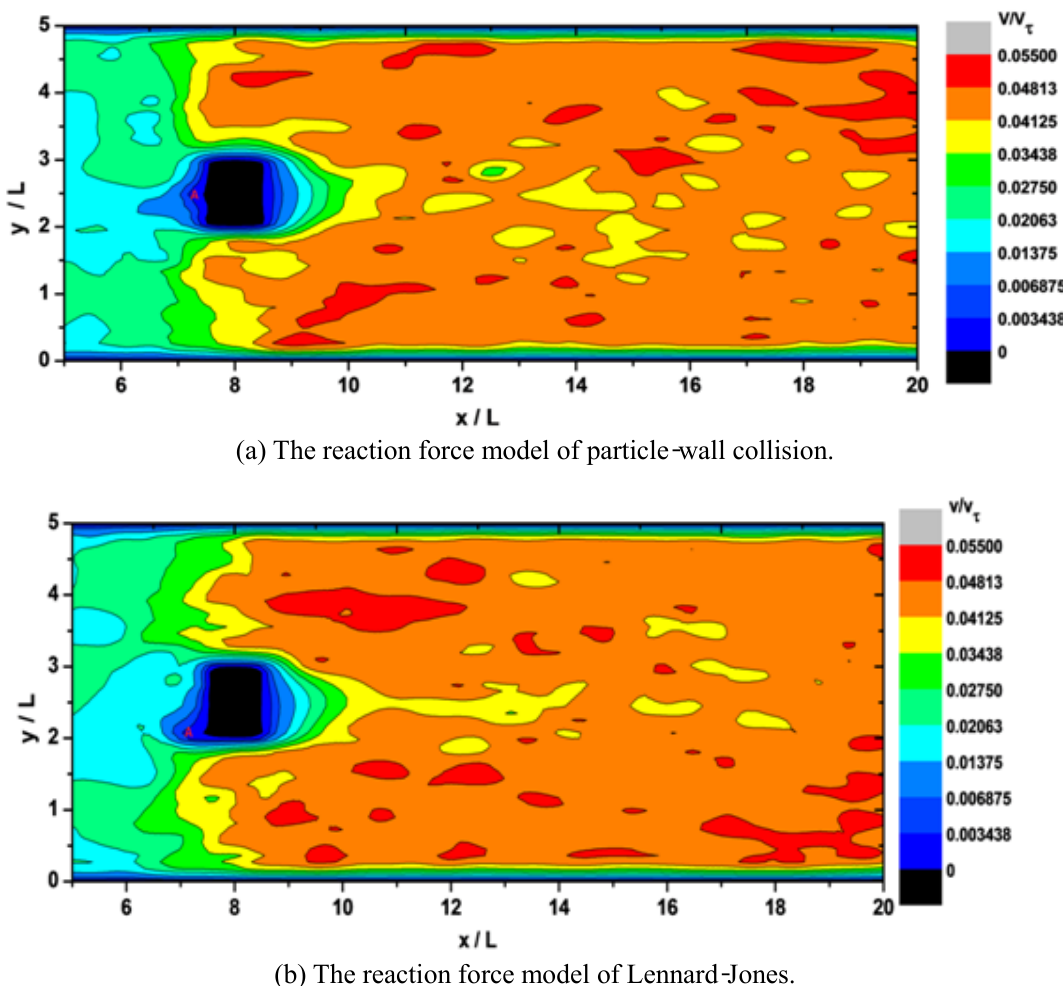
Fig. 10. Particles distributions at